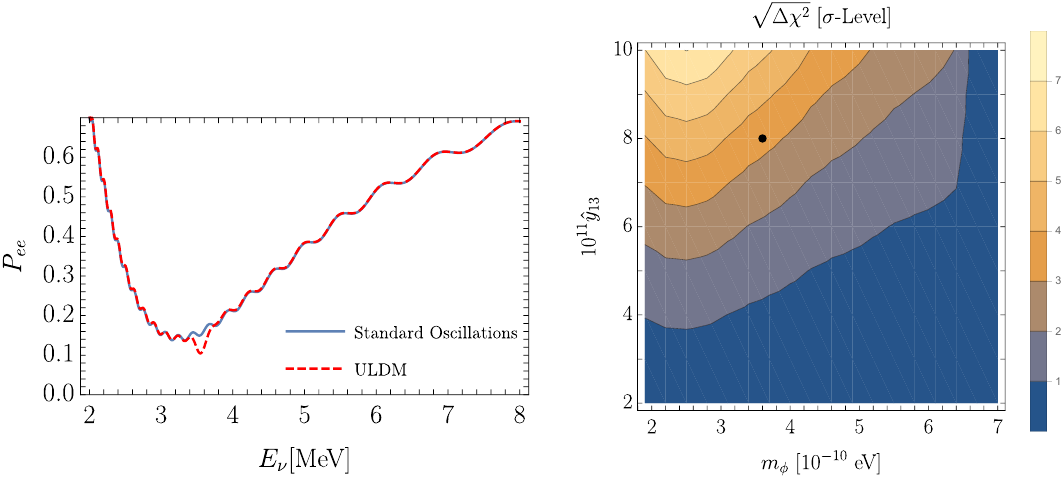
Figure 3 . The JUNO experiment: (Left) P ee ( E ) : the expected result from standard oscillations (blue), and the expected result for a ULDM field of m = 3 . 6 × 10 − 10 eV and ˆ y = 8 × 10 − 11 (red). φ 13 p ∆ (Right) : expected χ 2 between vacuum oscillations and oscillations in a ULDM field, assuming 60 days of data taking. KamLAND best fit parameters are marked by a black